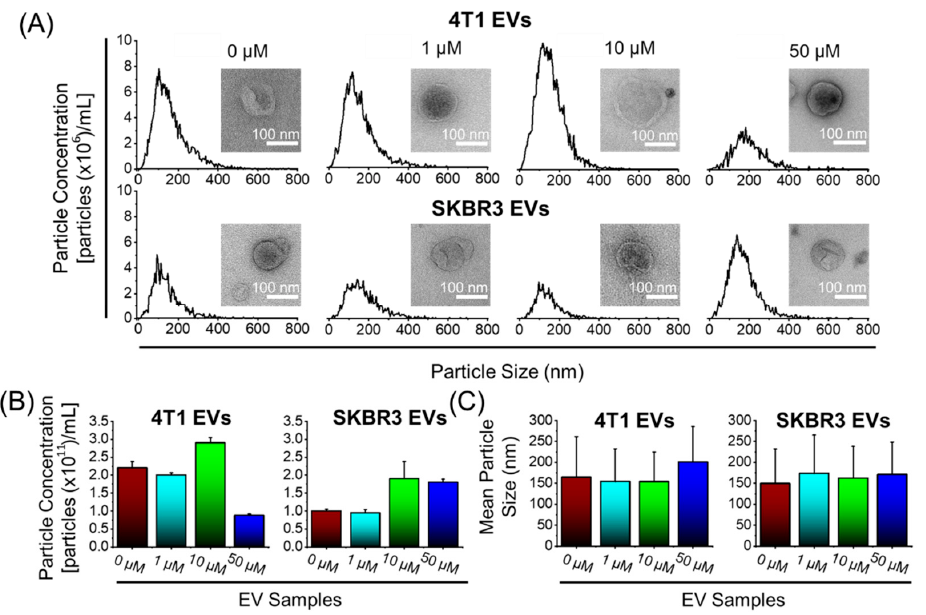
Figure 2. Biophysical characterization of 4T1 and SKBR3 EVs loaded with Dox. ( A ) Nanoparticle tracking analysis (NTA) was performed on EV pellets and a size distribution histogram for each EV sample is displayed. Transmission electron microscopy pictures of EV morphology (scale bar = 100 nm) (( A ), inset). ( B ) NTA with Zetaview TM was used to quantify the average particle concentrations (particles ×10 11 /mL) and ( C ) mean particle size (nm) of EV pellets. Data are presented as mean + SEM for three different EV preparations.